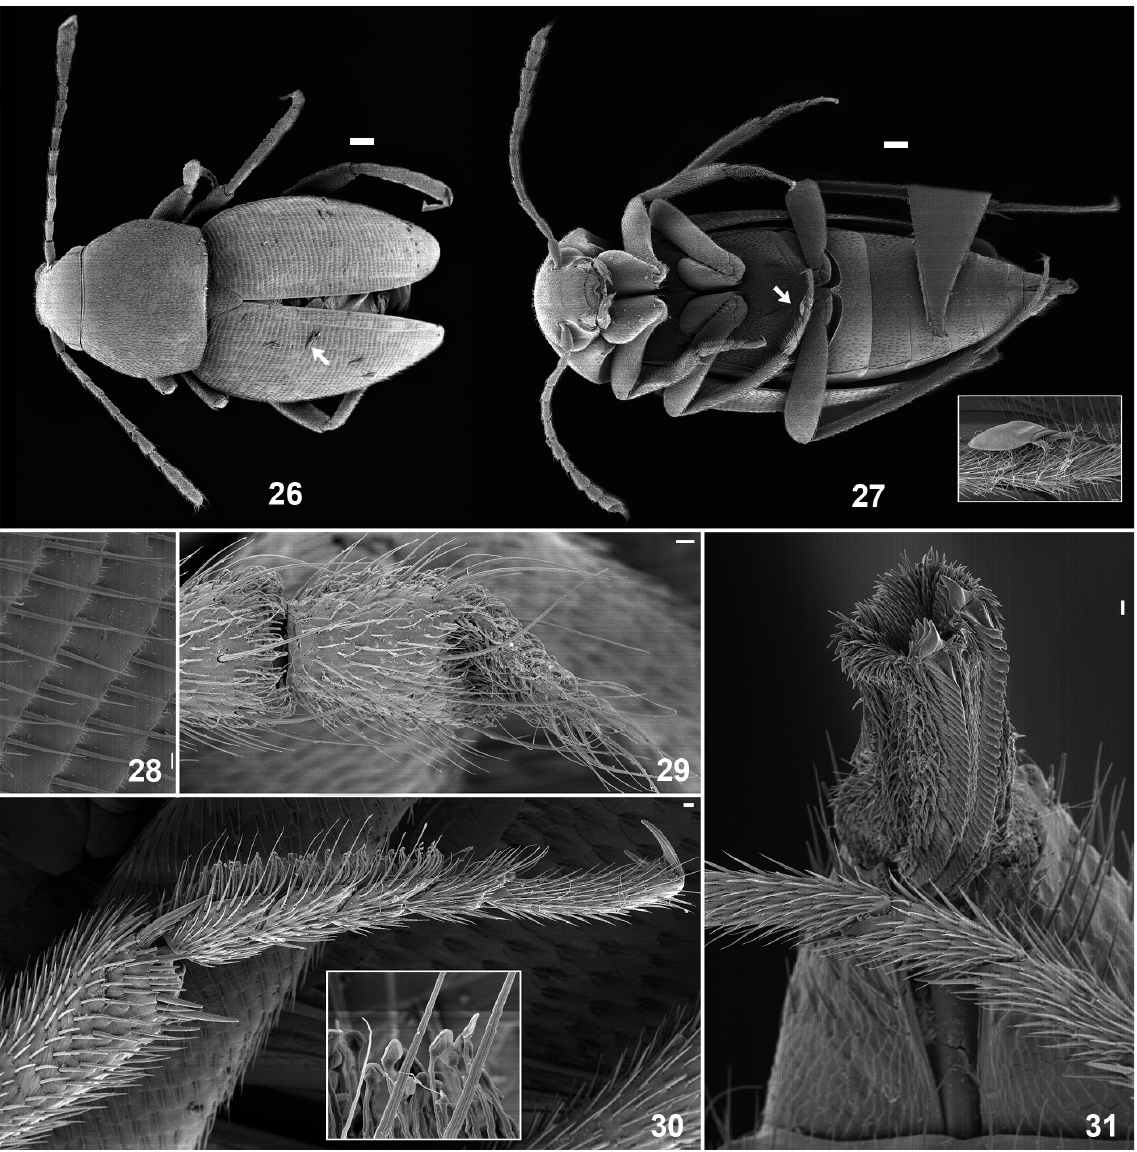
Figs 26-31. Speonemadus algarvensis sp. nov. scanning electron micrograph. 26 . Dorsal view with Laboulbeniales Stichomyces conosomatis pointed out. 27 . Ventral view, with detail of phoretic acari. 28 . Details of elytron stria and setation. 29 . Tip of the antenna. 30 . Male protarsus with detail of the ventral pads of the first tarsomere. 31 . Posterior dorsal view of the evaginated aedeagus. Scale bars 26–27 = 100 μm, 28–31 = 10